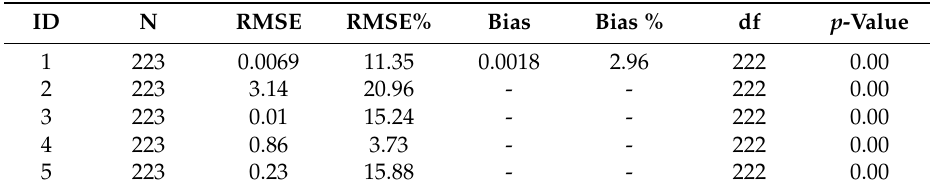
ID 1 indicates the relation between the ground CSA versus ground crown projection; ID 2 indicates the relation between the crown projection derived from UAV and ground data; ID 3 indicates the relation between the CSA derived from the UAV and ground data; ID 4 indicates the relation between the estimated height from the UAV and ground data; and ID 5 indicates the relation between the stem volume derived from the UAV and ground data. Forests 2018 , 8 , x FOR PEER REVIEW